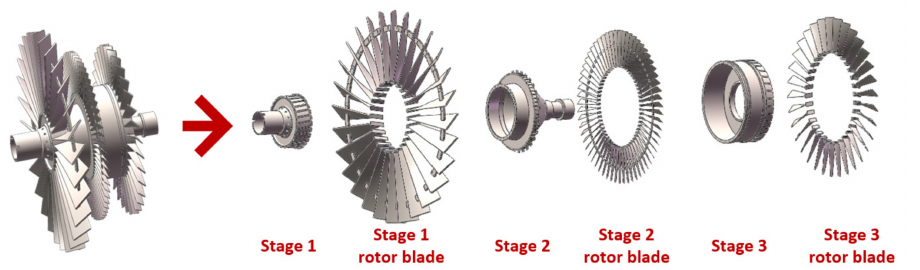
Figure 7. Main components of the fan